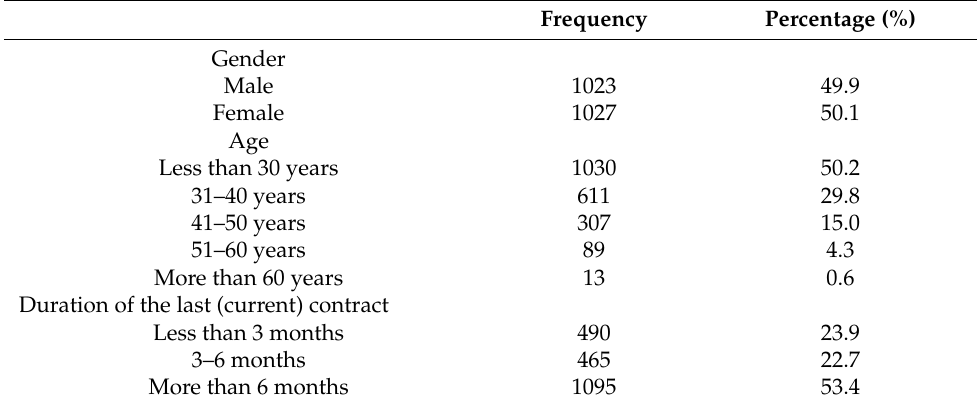
Table 1. Sociodemographic